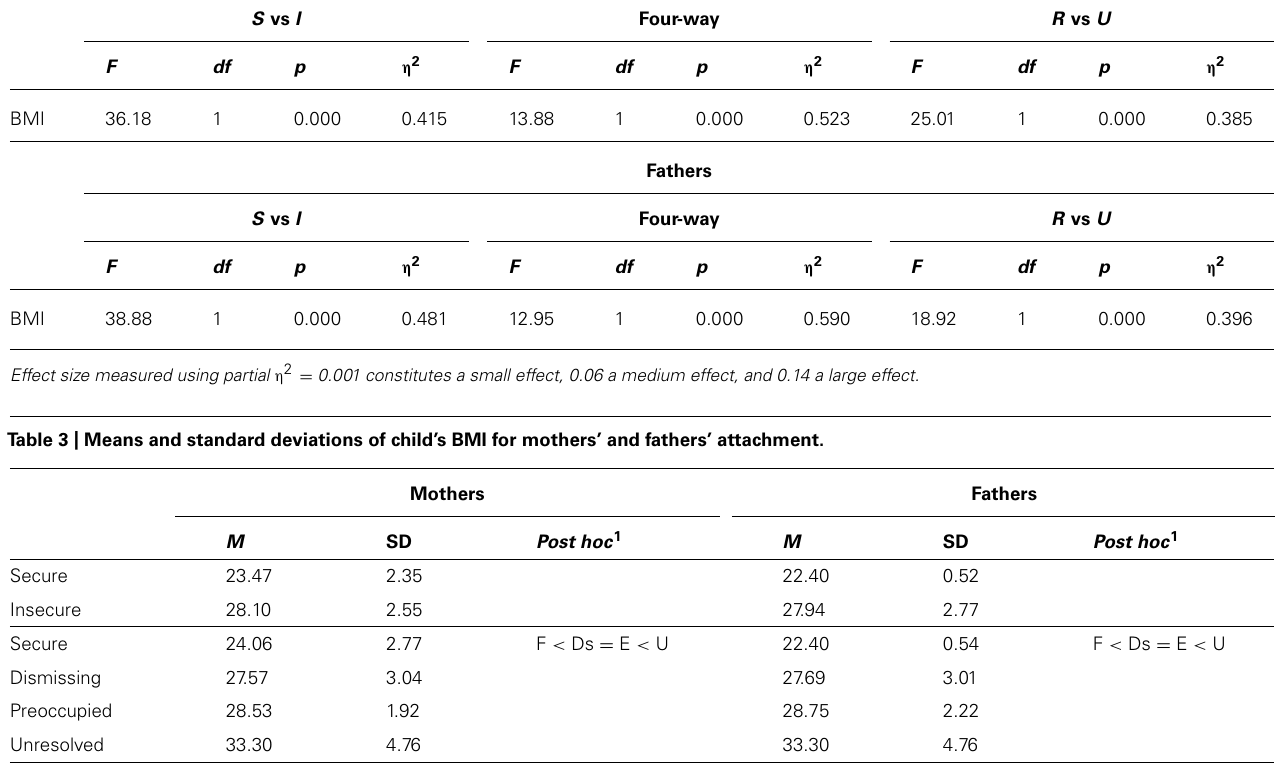
Mothers Four-way